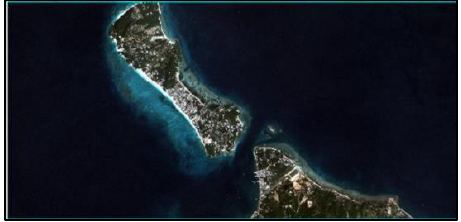
Figure 1. PlanetScope Imagery of Boracay